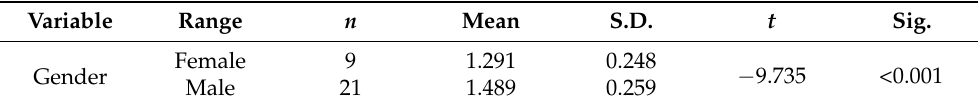
Table 1. Difference analysis of gender on pedestrian crossing speed.